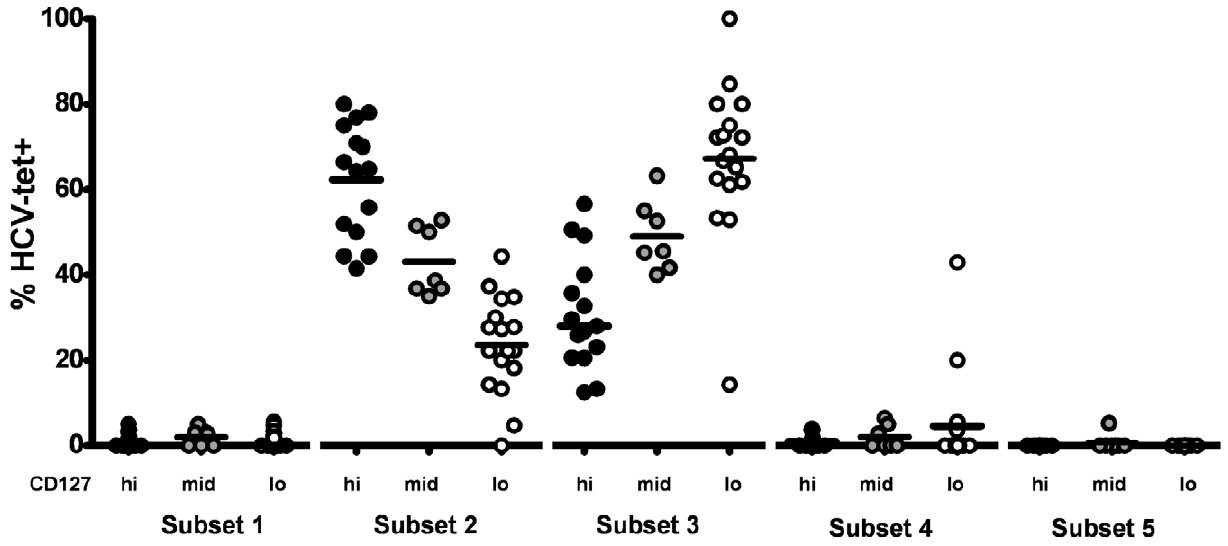
Figure 7. Differences in HCV-specific CD8 + T cell differentiation depending on CD127 expression. The frequency of HCV-specific CD8 + T cells identified in the differentiation subsets defined in Fig. 5A is depicted for CD127hi (Black circles), CD127mid (grey circles) and CD127lo (white circles) responses. Significant differences between CD127 subgroups were observed for differentiation subset 2 (p , 0.0001) and subset 3 (p , 0.0001). The majority of CD127hi responses was found in subset 2 (median 64,8%) while the majority of CD127lo cells was observed in subset 3 (median 68,1%). CD127mid cells were distributed at comparable levels in subset 2 (median 38,7%) and subset 3 (median 45,7%).